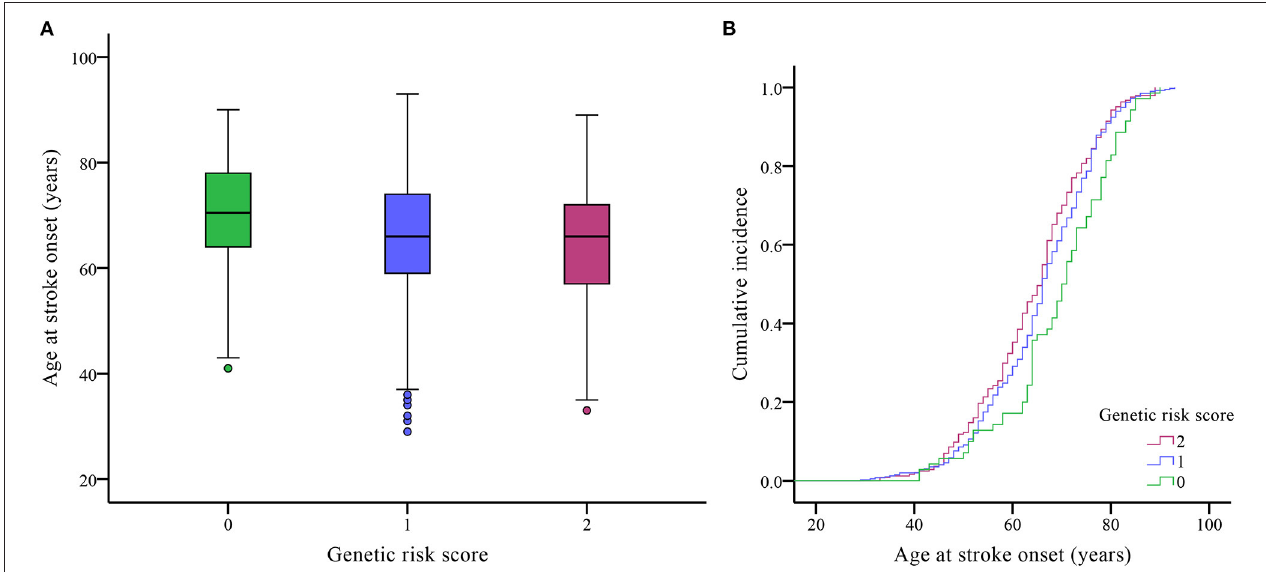
FIGURE 2 | Effects of the genetic risk score on the age of ischaemic stroke onset. (A) Box plot of age at onset in three genetic risk score groups ( P = 0.006). (B) Cumulative incidence curve of patients by genetic risk score (log-rank P = 0.010).